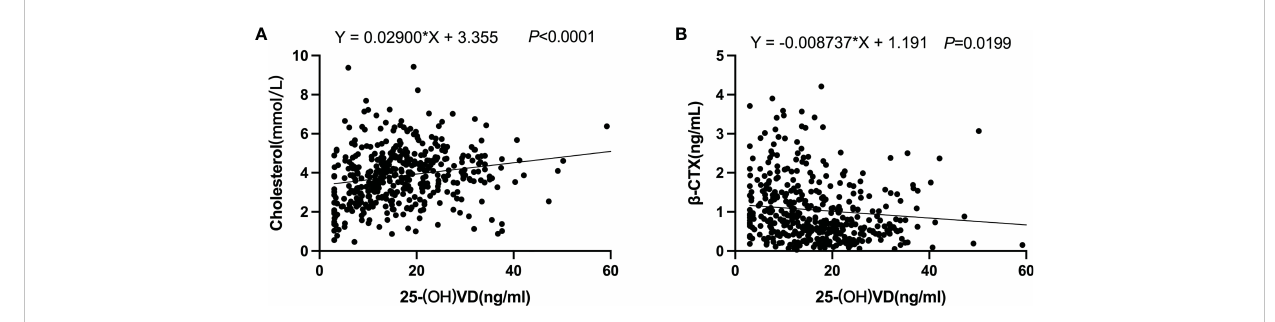
FIGURE 2 The correlation of vitamin D with cholesterol and b -CTX. (A) Cholesterol; (B) b -CTX.